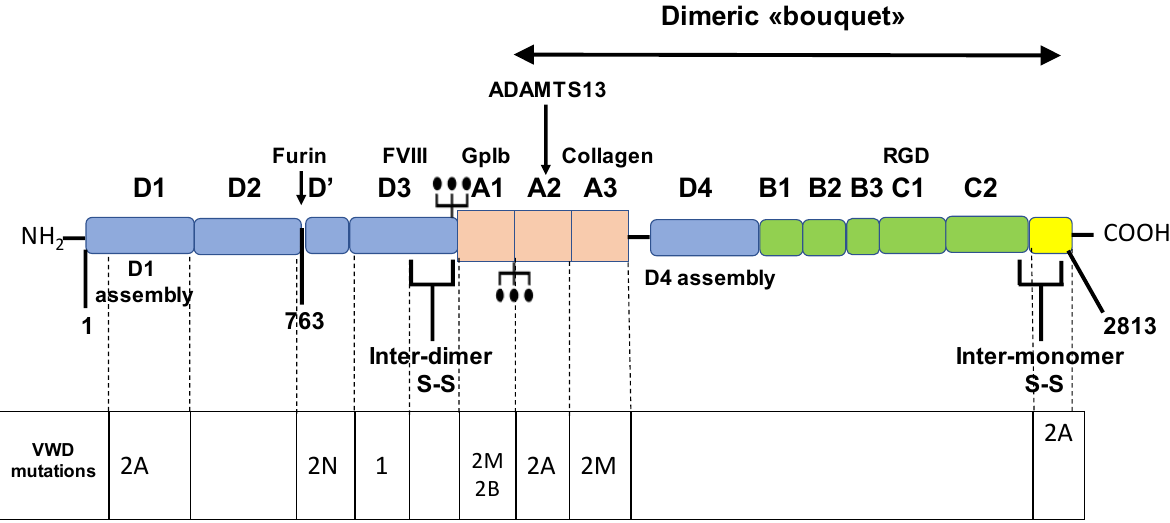
Figure 1: Schematic representation of the VWF monomer. VWF is synthesized as a pre-pro-VWF that comprises 763 residue propeptide, and the 2050-residue mature subunit. After initial removal of the signal peptide, the pro-VWF monomers associate in the endoplasmic reticulum in “tail-to-tail” dimers by the formation of disulfide bonds engaging the carboxyl-terminal CK domains (formation of the “dimeric bouquet”). Thereafter, dimers further multimerize by forming “head-to-head” disulfide bonds between the amino-terminus (D3 domain) in the Golgi apparatus. Some binding sites that are important for the hemostatic function of VWF are also indicated together with the ADAMTS13 cleavage site in the A2 domain. Relevant regions in which mutations have been found to be associated with VWD types 1 and 2 are also shown. The